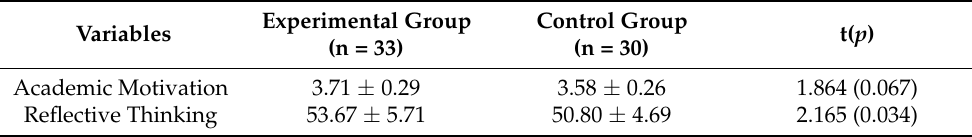
Table 4. Posttest differences between the experimental and control